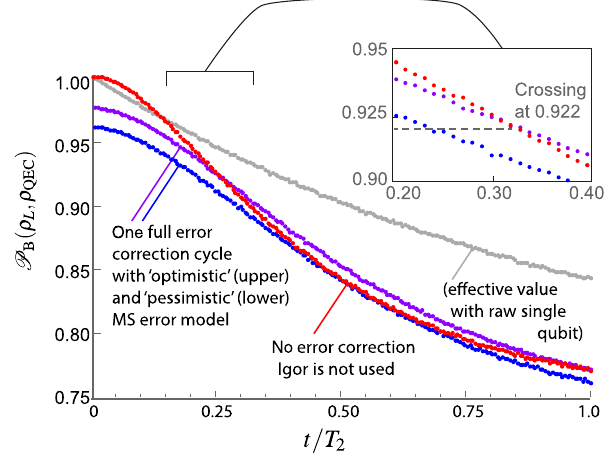
FIG. 24. Success probability P under the single-species, B shuttling-based QEC cycle with multiqubit MS gates (cf. Fig. 17): The parameters underlying the simulation correspond to the anticipated improved values from Tables II – V. We use two noise models for the imperfect five-ion MS gate operations involved in the stabilizer mappings: the optimistic model (i) of independent depolarizing channels [Eq. (14)] and the pessimistic model (iii) with a multiqubit depolarizing channel [Eq. (16)]. When we adopt the optimistic noise model and we employ Igor (purple curve), then for t=T 2 > 0 . 3 there exists a small advantage as compared to not using Igor to correct the logical qubit (red curve). Thus, Eq. (2) is fulfilled. However, when multiple qubit errors are fully enabled by the noise model, and we use the multiqubit depolarizing channel ( “ Igor, ” blue data points), the advantage disappears. This highlights the importance of modeling correlated errors appropriately, thus going beyond simplified error models that use the same single-qubit channel after each elementary operation in the quantum circuit. For reference, the behavior of an unencoded, bare physical qubit under the same environmental (dephasing) noise is also shown (grey data points). The inset shows a zoom of the parameter interval in which QEC becomes advantageous: For a total waiting time τ larger than about 300 ms, it becomes advantageous to apply an imperfect Igor QEC cycle but only for independent depolarizing noise. In this figure and those following, the inset shares the same axes labels as the main plot. FIG. 25. Success probability P under the two-species, shut- B tling-based QEC cycle with multiqubit MS gates (cf. Fig. 18): The building blocks is realized. We note that in Fig. 26 there is parameters underlying the simulation correspond to the antici- an additional curve, in green, which shows the effect of pated improved values from Tables II – V. The noise model for the applying Igor ’ s correction twice, at 33% and 67% of the imperfect five-ion MS gate operations corresponds to the worst- Alice-Bob time interval; again, one hopes to see the curves case noise model (iii) of multiqubit depolarizing noise [Eq. (16)]. Results show that there exists an ample parameter region (at times associated with Igor surpass the red or even the grey curves. larger than about 100 ms) in which the application of an imperfect Igor QEC cycle becomes advantageous [Eq. (2)] as compared to not applying it. Note that this takes place at P values of 0.981, B much higher than in the shuttling-based scenario 1, with a on, would be insufficient, in general, to prove a beneficial marginal gain at P values of about 0.92. Note that in the B QEC cycle: The curves representing the integrity of the present scheme, for not-too-long total times τ , below about logical qubit at the end of the period τ are strictly lower 200 ms, applying an imperfect QEC cycle is advantageous even when error correction is applied midway vs simply omitting as compared to a single, nonencoded physical qubit undergoing any such correction. This is principally caused by the dephasing noise of the same strength, such that the more-stringent complexity of the required circuits and by the higher error regime [Eq. (3)] for beneficial QEC can also be